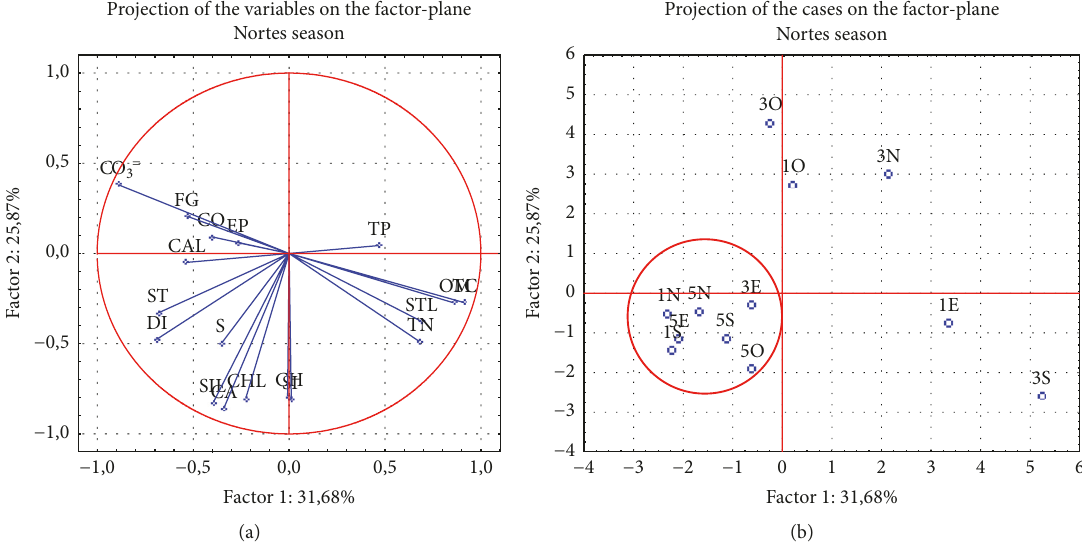
Figure 5: Principal Component Analysis (PCA) by variable (a) and site (b) based on the presence and concentration of sterols and stanols at each sampling station in Nortes season. The red circle identifies the group that contributes coprostanol (CO) and epicoprostanol (EP).